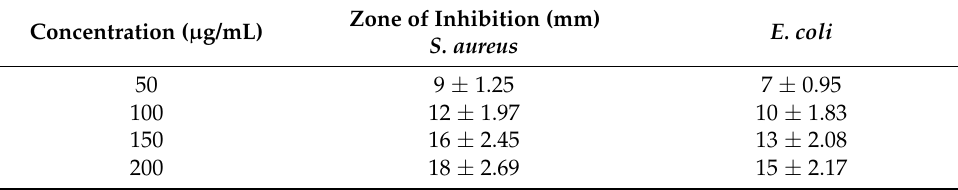
Table 2. Zone of inhibition of green synthesized Psidium guajava Co 3 O 4 NPs against gram +ve ( Staphylococcus aureus ) and gram − ve ( Escherichia coli ) bacteria. Results are represented as mean ± SD, triplicate